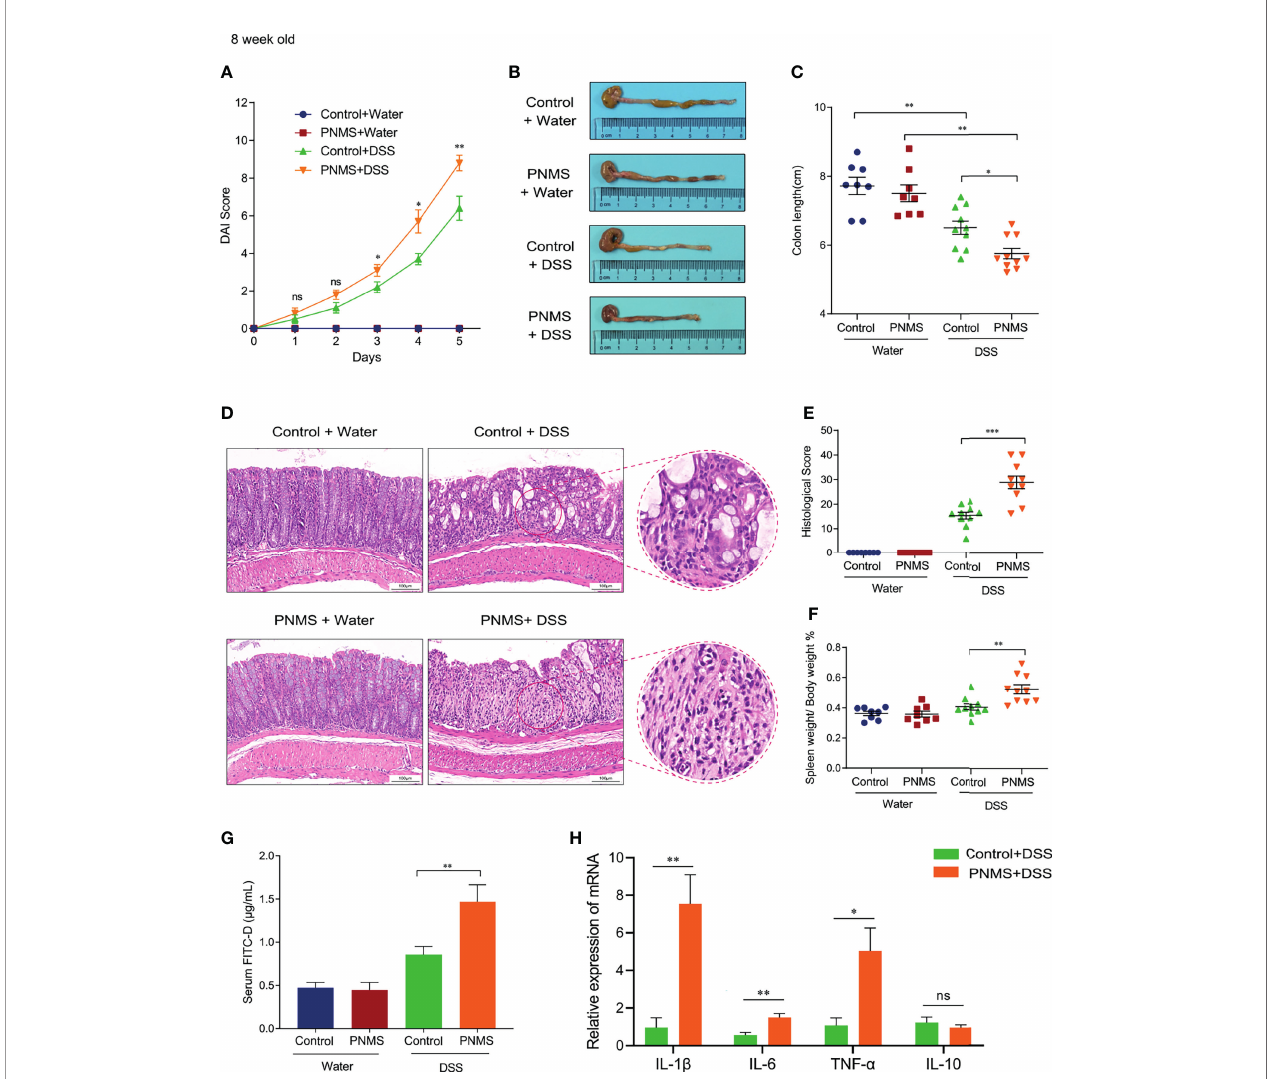
FIGURE 7 | Prenatal maternal stress aggravated the severity of experimental colitis in adult mice. (A) Disease activity index (DAI) scores during the process. (B) Colon appearance after treatment. (C) Colon lengths. (D) Histopathological changes of the colon section detected by hematoxylin and eosin (HE) staining. (E) Histological scores of colonic in fl ammation. (F) Ratio of spleen weight to body weight. (G) Fluorescein isothiocyanate – dextran (FITC-D) intestinal permeability assay. (H) Relative mRNA expressions of the in fl ammation factors in the colon. PNMS , prenatal maternal stress; DSS , dextran sulfate sodium. Scale bar , 100 m m. Magni fi cation, ×200. * p < 0.05, ** p < 0.01, *** p < 0.001. Control+Water ( n = 8), PNMS+Water ( n = 8), Control+DSS ( n = 10), PNMS+DSS ( n = 10). ns, P <